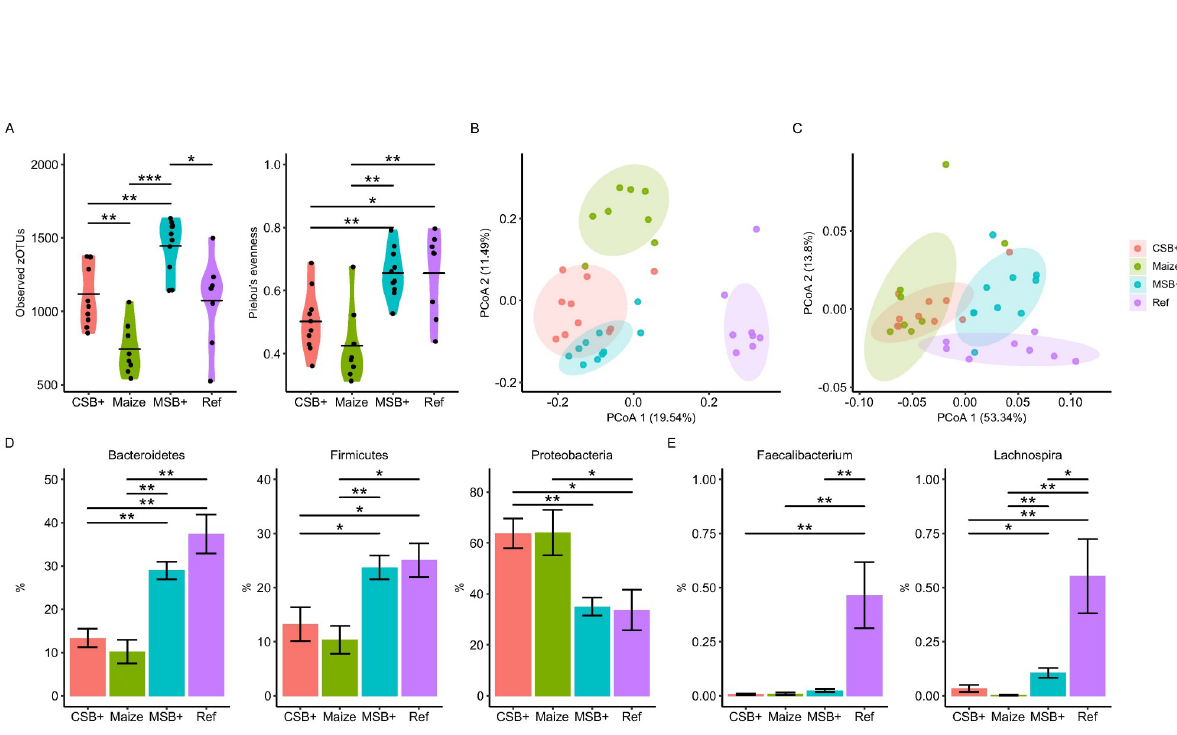
PLOS ONE | https://doi.org/10.1371/journal.pone.0250423 April 29,